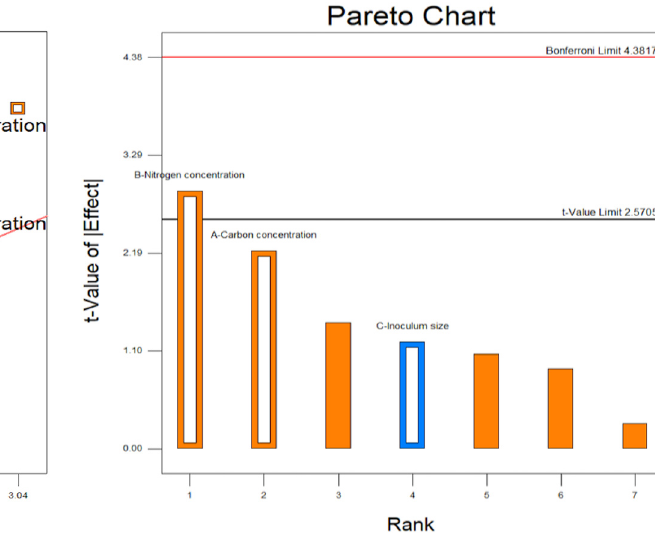
Figure A1: Half normal plot analysis of the e ff ect of di ff erent glucose and peptone concentrations, as well as di ff erent inoculum sizes, on BC yield ( g/L ) produced by P. kudriavzevii USM - YBP2 at 30°C, agi - tated at 200 rpm.